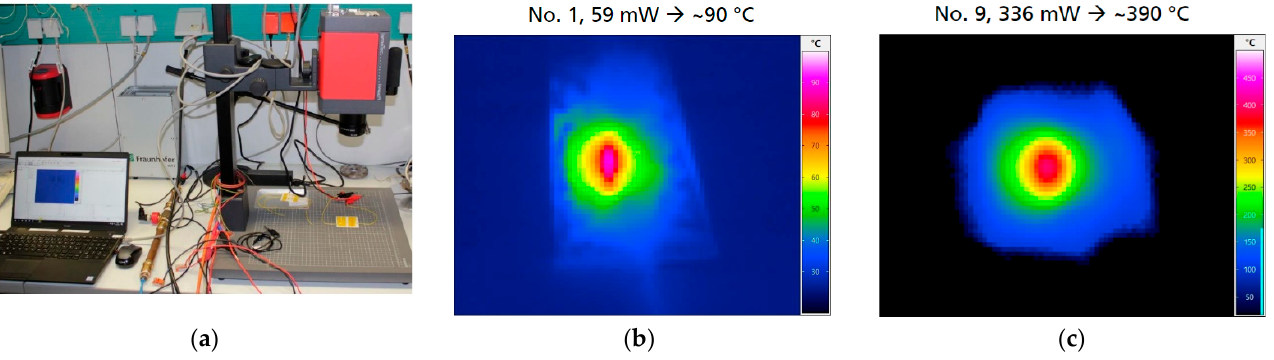
Figure 8. Result of platinum-printed microhotplate testing: ( a ) Photo of testing installation with an IR camera and placement of the Pt-heater chip underneath; ( b ) IR image at 90 °C working temperature for microhotplatehot spot with power consumption of 59 mW; and ( c ) IR image at 390 °C working temperature for microhotplate hot spot with power consumption of 336 mW.